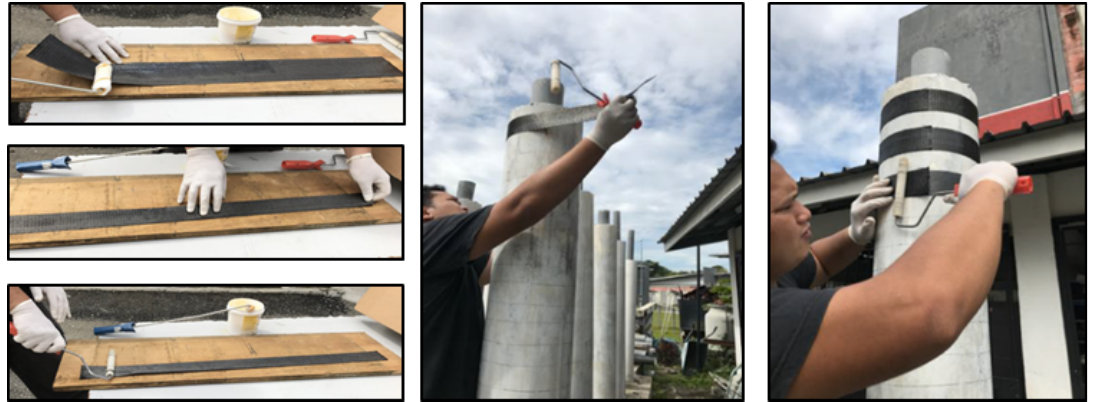
Figure 2. Partial CFRP Installation; (a) Adhesive Application on CFRP Strip (b) CFRP Strip Installatin on Concrete Surface.